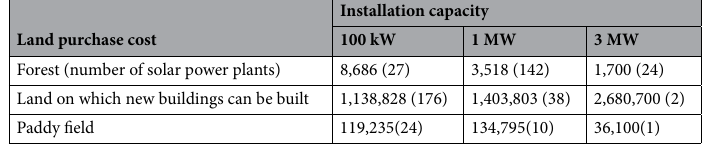
Table 7. Land purchase cost according to installation capacity of solar power plant (unit: Korean won/m 2